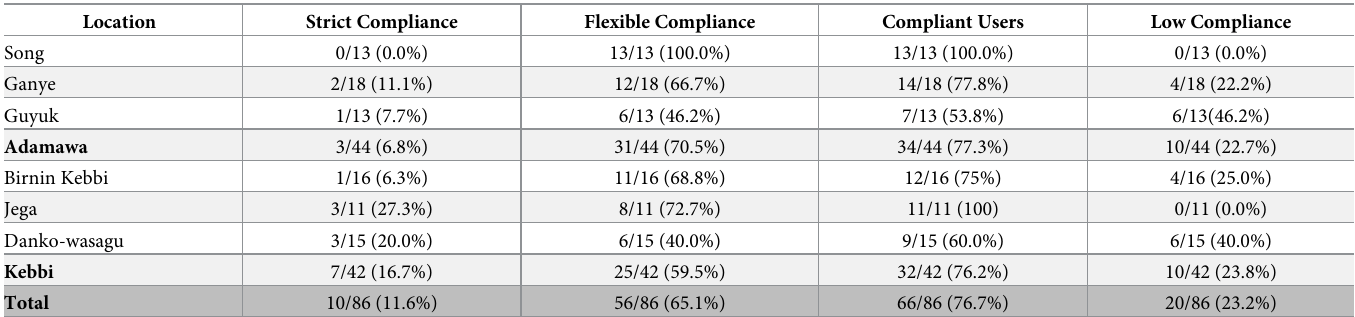
Table 1. Spot check data by type of user and geographic location. Location